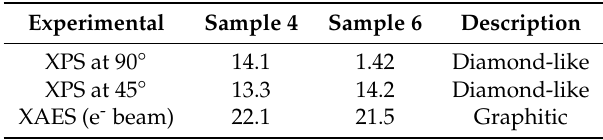
Table 4. D parameter (eV) determined by XPS and XAES for graphene samples on Cu substrate